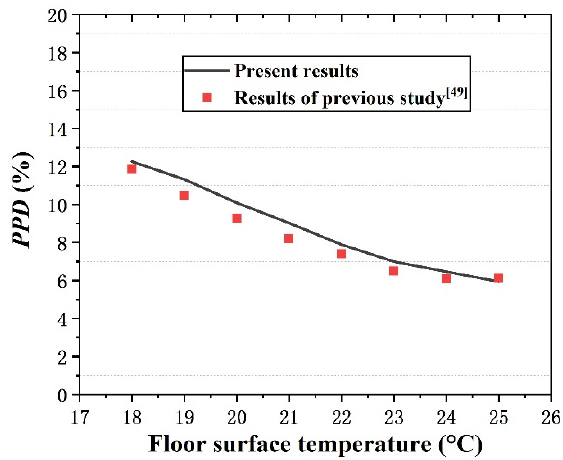
Figure 6. Results of the present study compared with a previous study [49].